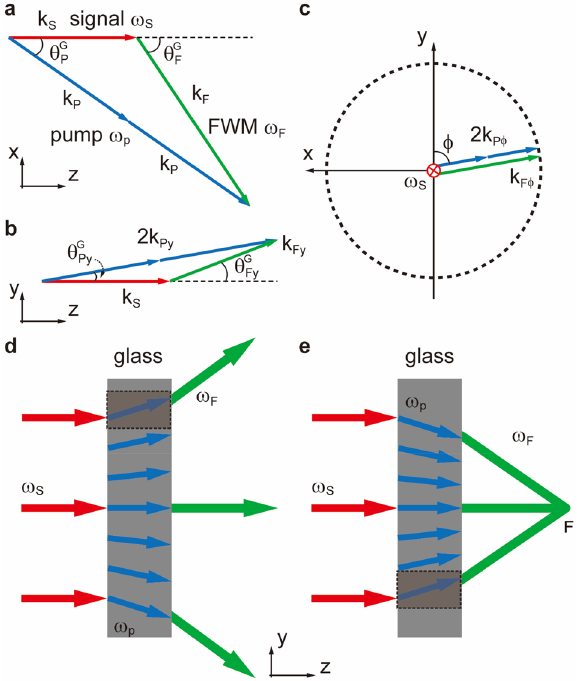
Figure 1. Schematic of nonlinear refractions of a degenerate FWM. Phase matching triangle in the x ~ z , y ~ z, and x ~ y planes, k symbolizes the wavevectors for each component in the FWM process. ( a ) In the x ~ z plane, θ G θ G p and F are the incident and emittance angles within the glass slab fulfilling the phase matching condition 2 � k − � k = � k . ( b ) The matching condition of the wavevectors in the y ~ z plane, marked as 2 k py and k Fy form p s F a new triangle-like relation with unchanged k s in direction + z , where a new pair of angular relation of θ G py and θ G Fy is brought in. Such a relation could be tuned within tolerance. ( c ) The projections of the above wavevectors in the x ~ y plane denoting as k pϕ and k Fϕ are a few degrees deviated from the orthogonal ( ϕ = 90°) position. All the possible endpoints for 2k pϕ and k Fϕ lead to a dashed circle in the x ~ y plane. ( d ) For the case of a diverging pump beam onto the slab, the FWM beam also exhibits a diverging trend accordingly, due to the local